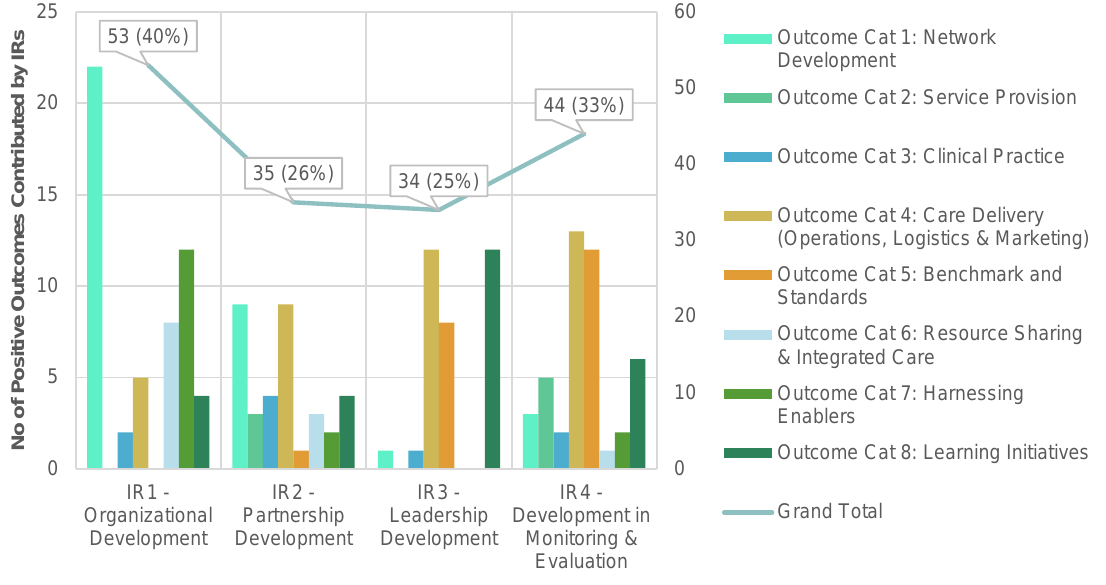
Figure 4. Positive outcomes ( N = 134) a contributed by intermediate results (IRs) b . a Please refer to breakdown of positive outcomes according to categories in Table A2 in Appendix A. b Some outcomes have been contributed by more than one IRs, so the sum of percentages have exceeded 100 percent.